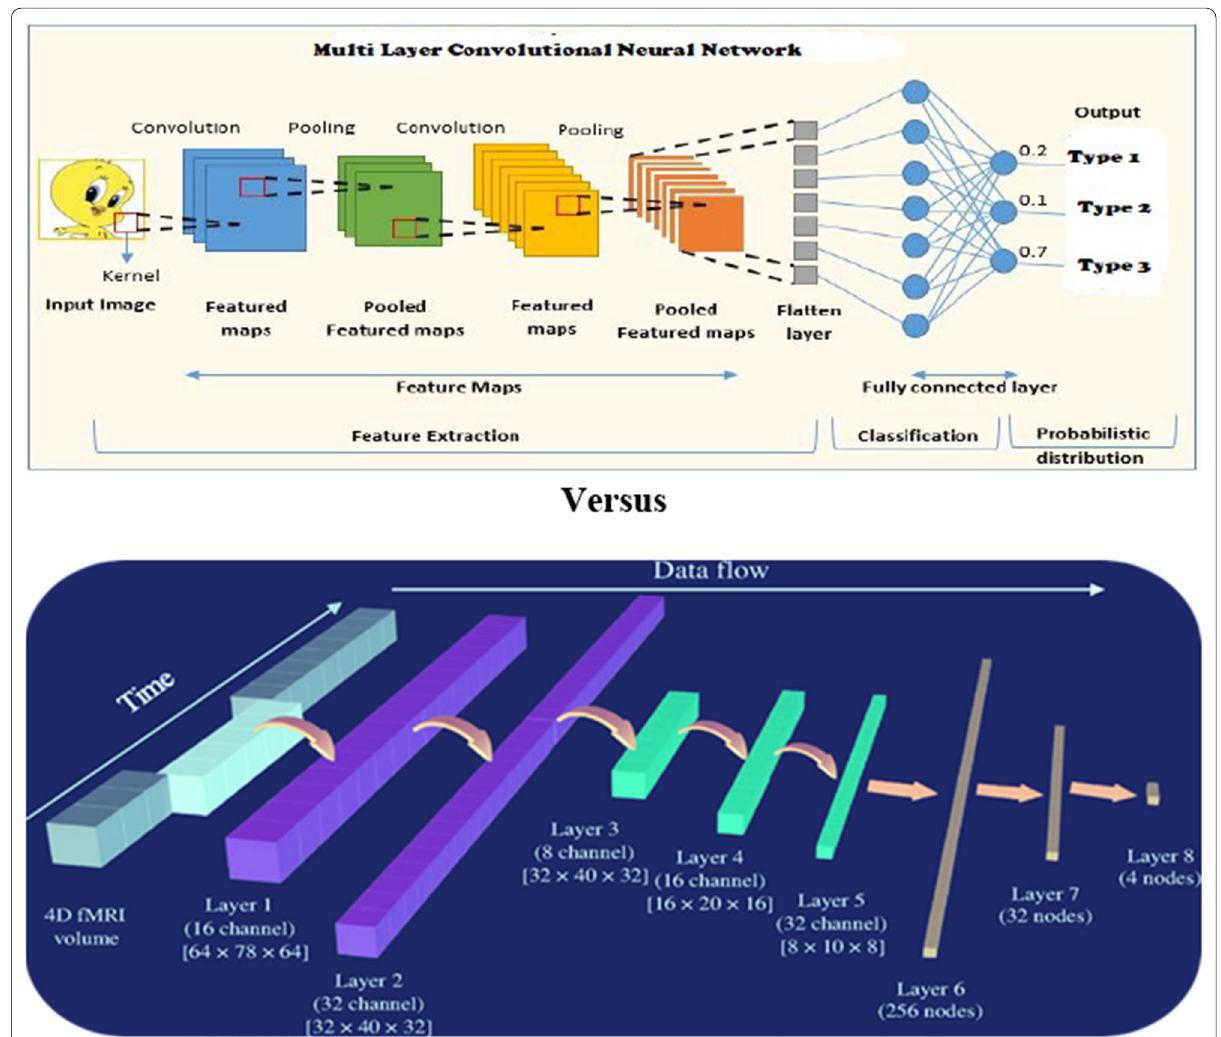
Fig. 1 Multiple layers convolution neural network architecture versus 3D convolution neural network architecture